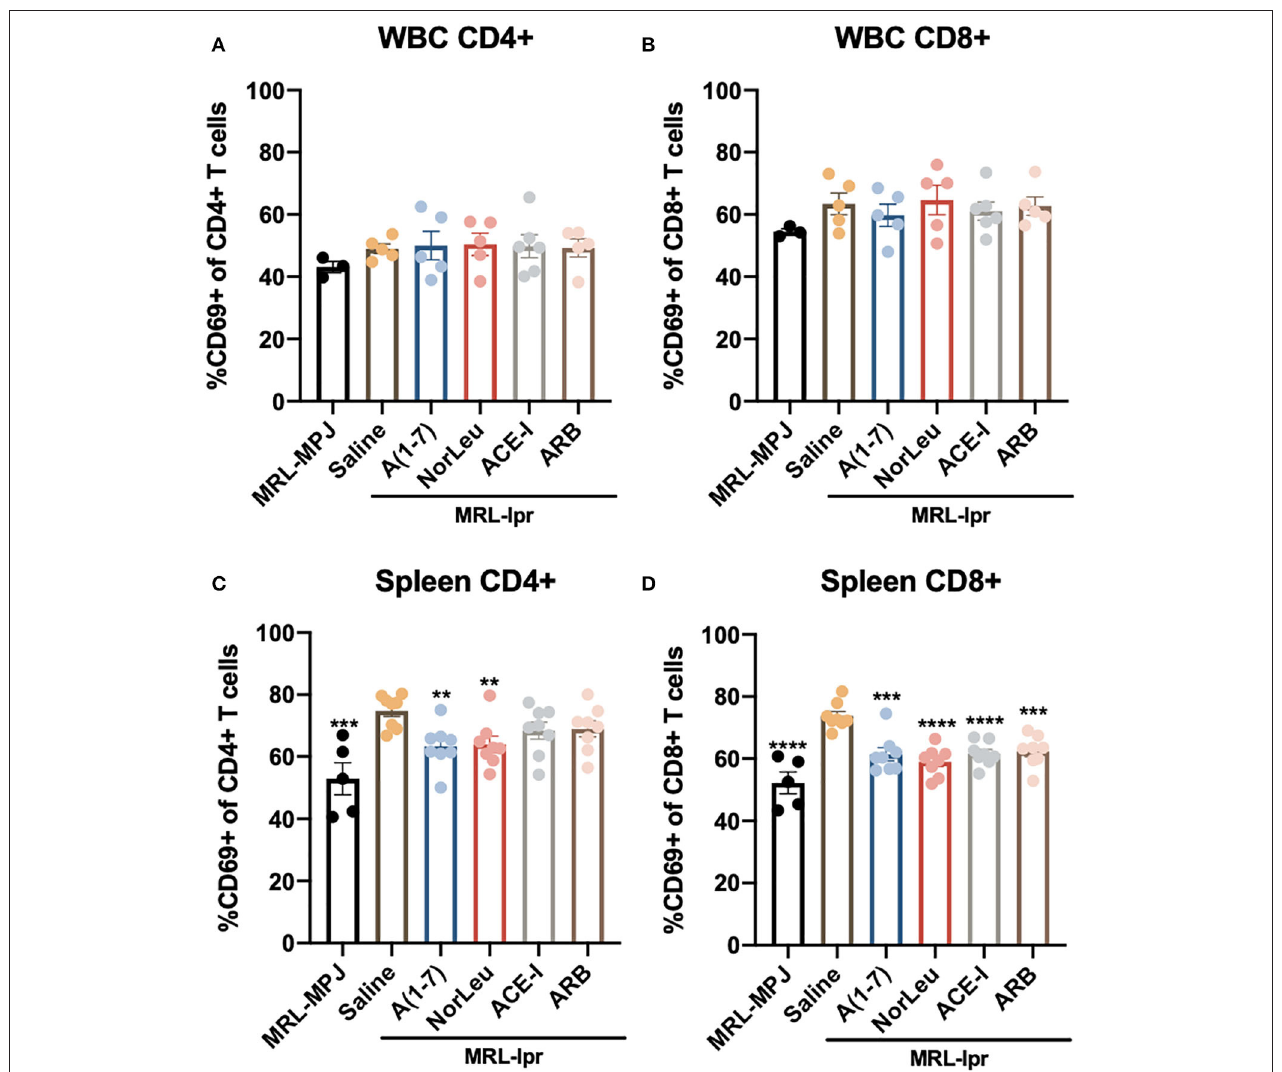
FIGURE 3 | Splenic but not circulating T cell activation is affected in MRL -lpr mice, and rescued with RAS-modulating therapies. At necropsy, splenic cells, and WBCs were isolated and stained for T cell markers (CD3, CD4, CD8) and the T cell activation marker CD69. Samples were then analyzed by flow cytometry. T cells were identified as CD45 + CD3 + and then either CD4 + or CD8 + . The gating strategy for the T cell characterization can be found in Supplemental Figure 5 . CD69 was measured in both CD4 and CD8T cells in the blood (A,B) and in the spleen (C,D) . Statistical analysis were done using Prism 8.4.0, t -tests were used to compare all groups to saline treated MRL -lpr mice; ** p ≤ 0.01, *** p ≤ 0.001, **** p ≤